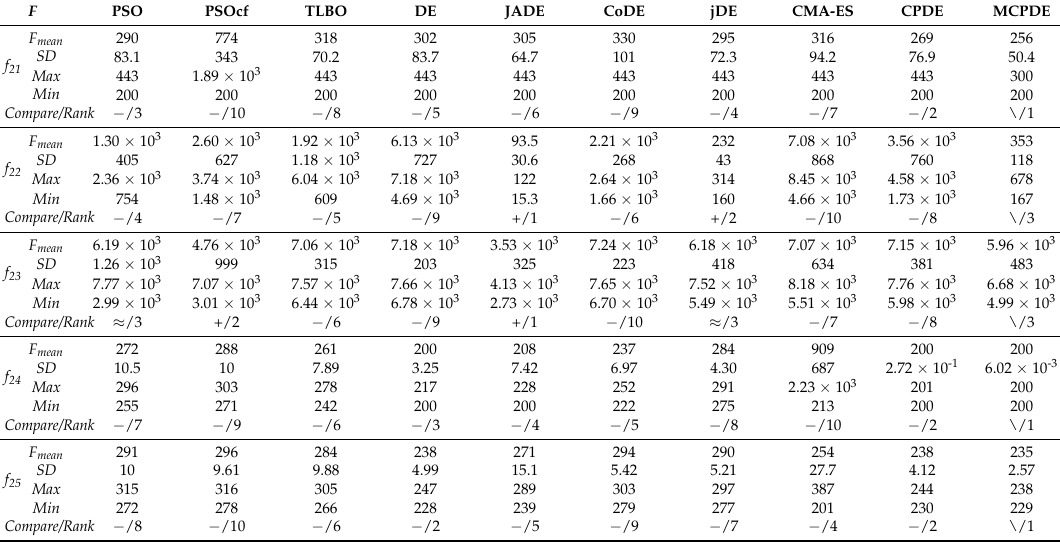
Table 6. Experimental results of PSO, PSOcf, TLBO, DE, JADE, CoDE, jDE, CMA-ES, CPDE and MCPDE over 30 independent runs on f 21 – f 28 test functions with 30 D